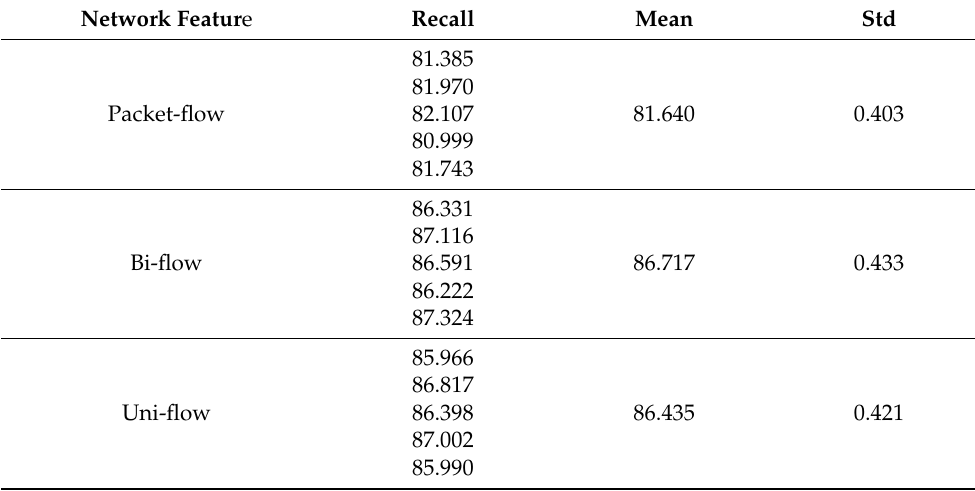
Table 15. Multi-class attacks classification results in term of recall.